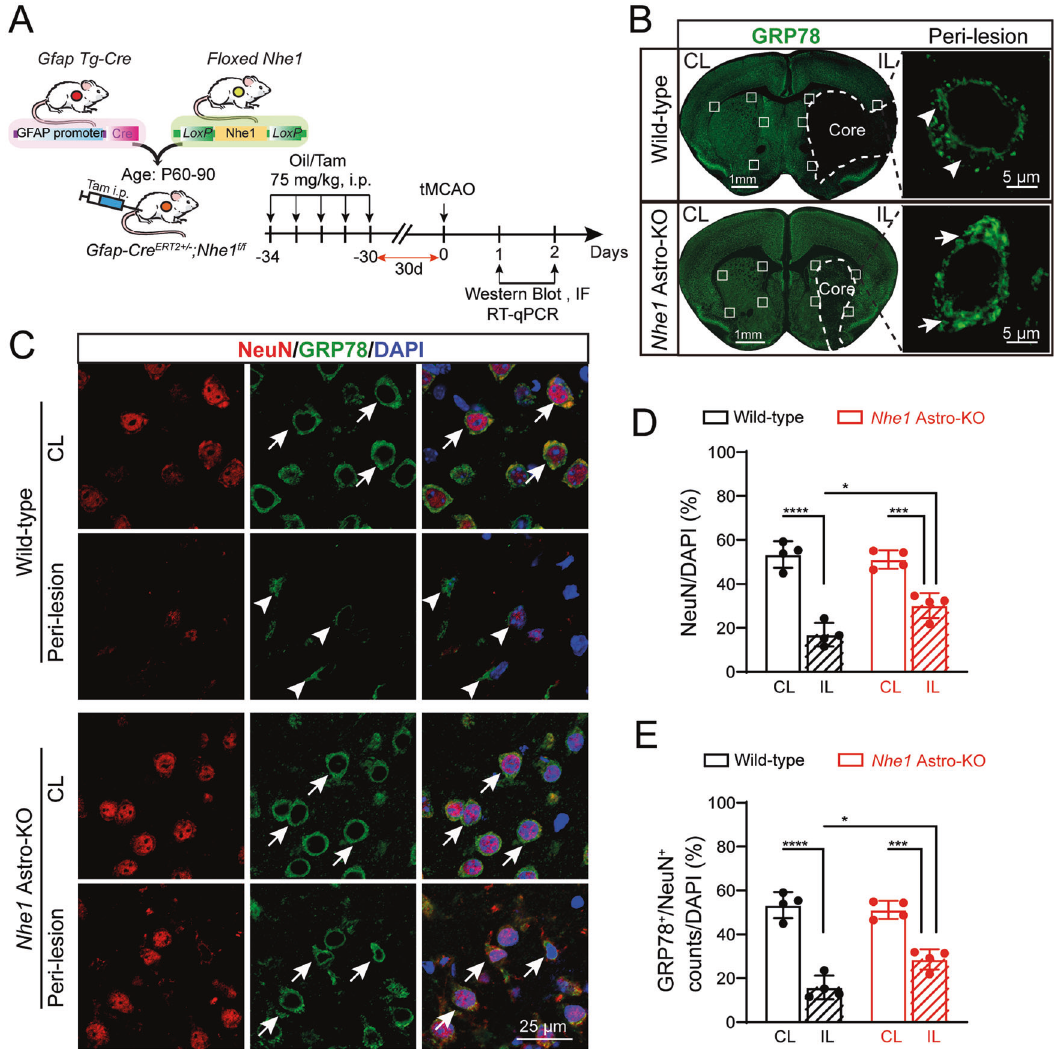
Fig. 1 Nhe1 Astro-KO brains displayed preserved neuronal GRP78 expression and NeuN + cell counts after ischemic stroke. A Experimental protocol and timeline. B Representative immuno fl uorescence images of GRP78 protein expression in wild-type and Nhe1 Astro-KO brains at 48 h Rp. High magni fi cation images show peri nuclear GRP78 staining in peri-lesion areas indicated by white squares. C Representative confocal images of NeuN and GRP78 staining in neurons. Arrows : high GRP78 protein expression. Arrowheads : low GRP78 expression. D, E Summary data of GRP78 + and NeuN + cells. Data are mean ± SD, n = 4. * p < 0.05; ** p < 0.01; *** p < 0.001; **** p < 0.0001 via one-way ANOVA. CL contralateral, IL Ipsilateral